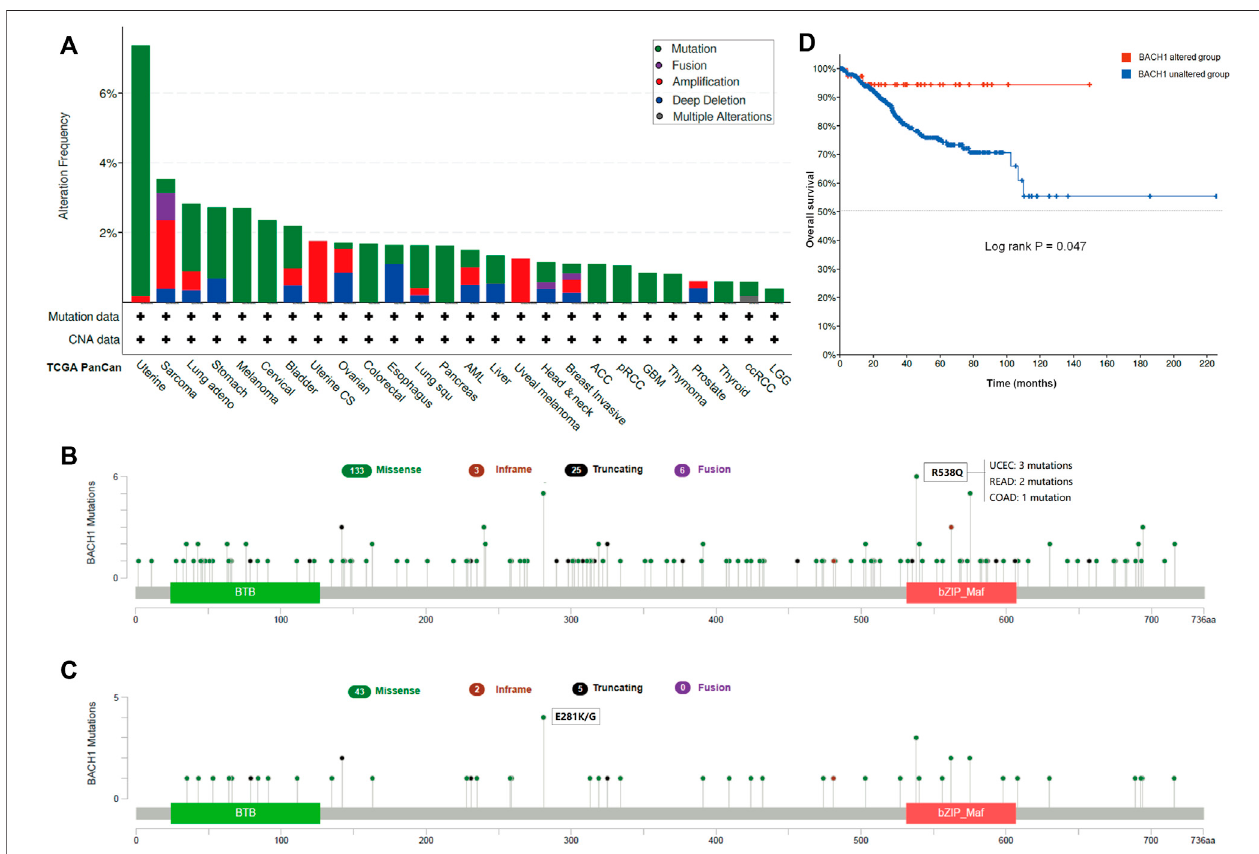
FIGURE 3 | Pan-cancer Mutation Landscape of BACH1. (A) Distribution of BACH1 mutation types in different cancers (B) Common mutation sites of BACH1 in different cancers. (C) Common mutation sites of BACH1 in UCEC (D) The overall survival of UCEC patients with BACH1 mutation.